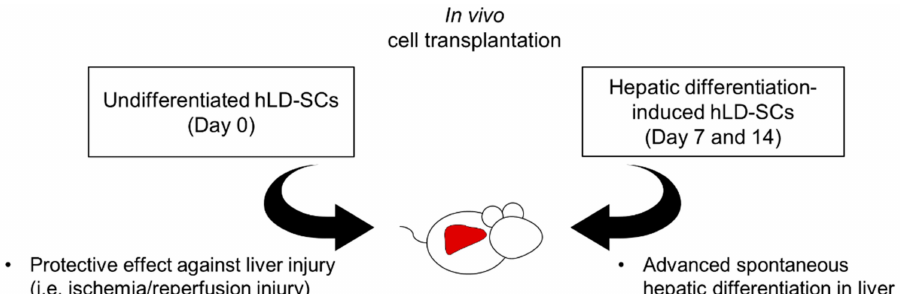
Figure 7. Schematic summary of in vitro characteristics during chemical-based hepatic di ff erentiation. Human liver-derived stem cells (hLD-SCs) were pluripotent, expandable, and exhibited MSC-like structures with elongated spindle shape and ovoid nuclei. The hLD-SCs expressed high levels of endodermal genes ( GATA4 and FOXA1 ). On day 7 of the two-step chemical-based hepatic di ff erentiation, hLD-SCs had a higher oxygen consumption rate (OCR), which related to the di ff erentiation potency of MSCs. On day 14, hLD-SCs expressed high levels of the hepatic progenitor cell markers, CPM and CD133 , with a consistent increase in hepatocyte maturation-related gene expression ( HNF1A , HNF4A , and AFP ). On day 21 of the two-step di ff erentiation, hLD-SCs showed standard characteristics of mature hepatocyte-like cells with the conversion from a flat oval to a rough circle. In vivo cell transplantation of undi ff erentiated hLD-SCs exerted protective e ff ects against liver injury and hepatic di ff erentiation-induced hLD-SCs that were spontaneously di ff erentiated into mature hepatocyte-like cells.